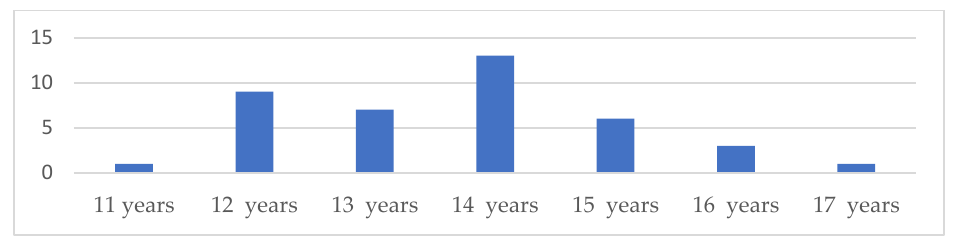
Figure 2. Ages of the participants.